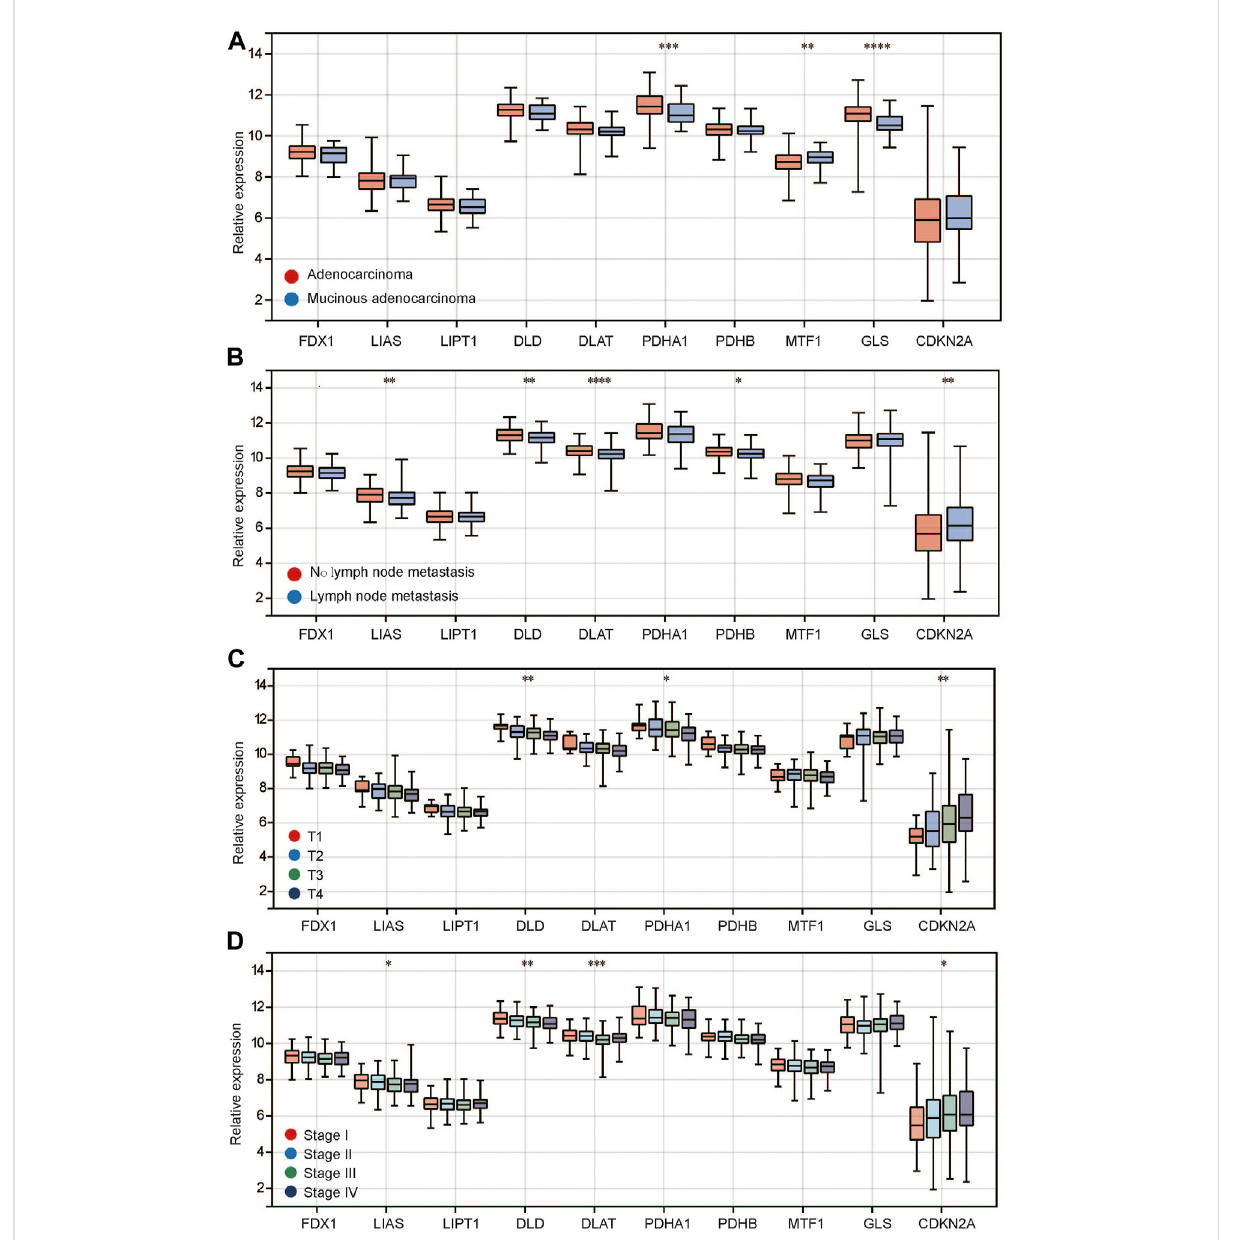
Relationship between CRG expression and clinical characteristics of colorectal cancer. (A) CRG expression in different histopathological types; (B) CRGexpressionindifferentstatusoflymphnodemetastasis; (C) CRGexpressionindifferentTstages; (D)